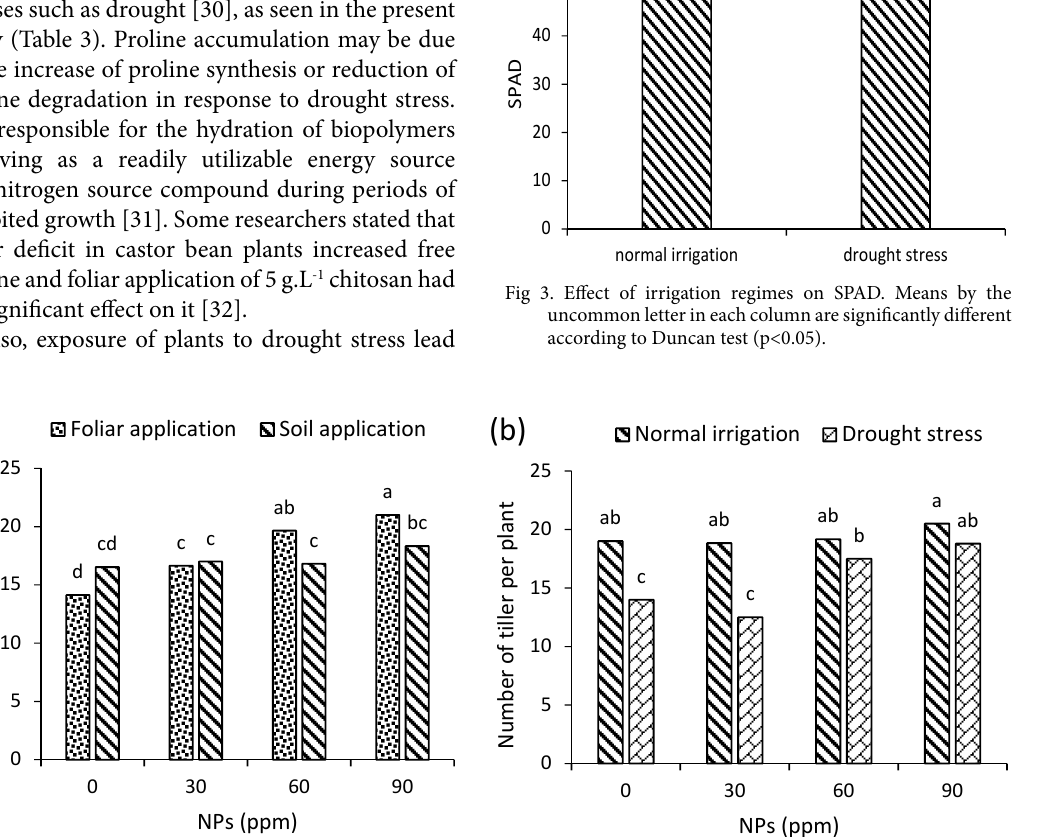
Fig 4. The effect of NPs concentration, application method and irrigation regime on number of tiller. Means by the uncommon letter in each column are significantly different according to Duncan test